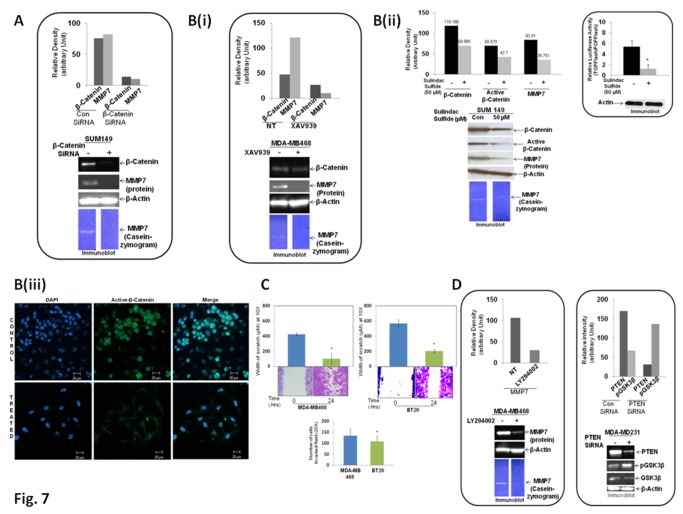
An attenuation of WP caused downregulation of MMP7 in PTEN null TNBC cells.PTEN null MMP7 expressing TNBC cell line, SUM149 was transiently transfected with beta-catenin SiRNA and MMP7 protein and its enzymatic activity were determined by Western blot and casein zymography respectively (A). Upper bar diagram showed the relative desitometric expressions of beta-catenin and MMP7. Pharmacological attenuation of beta-catenin in PTEN null MMP7 expressing TNBC cell lines, MDA-MB468 (B i) and SUM149 (B ii) following the treatment with XAV939 (B i) and sulindac sulfide (B ii) caused a decrease in MMP7 protein expression as well as an abrogation of its enzymatic activity. Upper bar diagrams showed the relative desitometric expressions of beta-catenin, active beta-catenin and MMP7. Relative luciferase activity (TOP Flash over FOP Flash) measured in SUM149 cells following sulindac sulfide was plotted (three different experiments). Error bars represent standard error of the means (SDs), and statistical significance was determined by paired t-test. *P < 0.05. The lower panels showed images of Western blot measuring β-actin (Inset of B ii). Sulindac sulfide treatment substantially reduced nuclear immune-fluorescence of beta-catenin (active form) in TNBC cells (B iii). To find out the involvement of MMP7 in metastasis-associated phenotypes, fibronectin-directed migration (C, upper panel) and matrigel-invasion (C, lower panel) were determined in MMP7 expressing MDA-MB468 cells and MMP7 null BT20 cells. Error bars represent standard error of the means (SDs), and statistical significance was determined by paired t-test. *P < 0.05. Since the pan PI3K inhibitor, LY294002 has been shown to closely mimic the effects of PTEN reconstitution in PTEN-deficient cancer cells, to understand the role of PTEN on the expression/enzymatic activity of MMP7 in TNBC cells, we have treated PTEN null MMP7 expressing MDA-MB468 cells with LY294002 (D). Data showed a decrease in MMP7 following LY294002 treatment in MDA-MB468 cells.